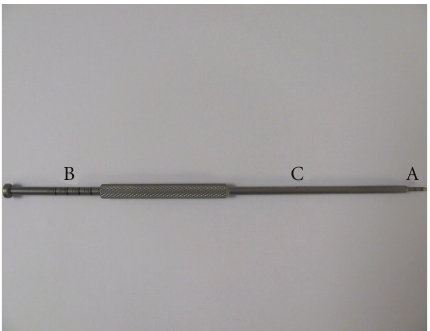
Figure 1: The assembled intra-articular depth guide. A: needle- tipped inner metallic probe used to penetrate the rotator cuff and measure the exposed bone bed. B: the distal end of the inner metallic probe is marked with numbers to measure total tendon thickness. C: outer metallic sleeve slides freely over the inner metallic probe.